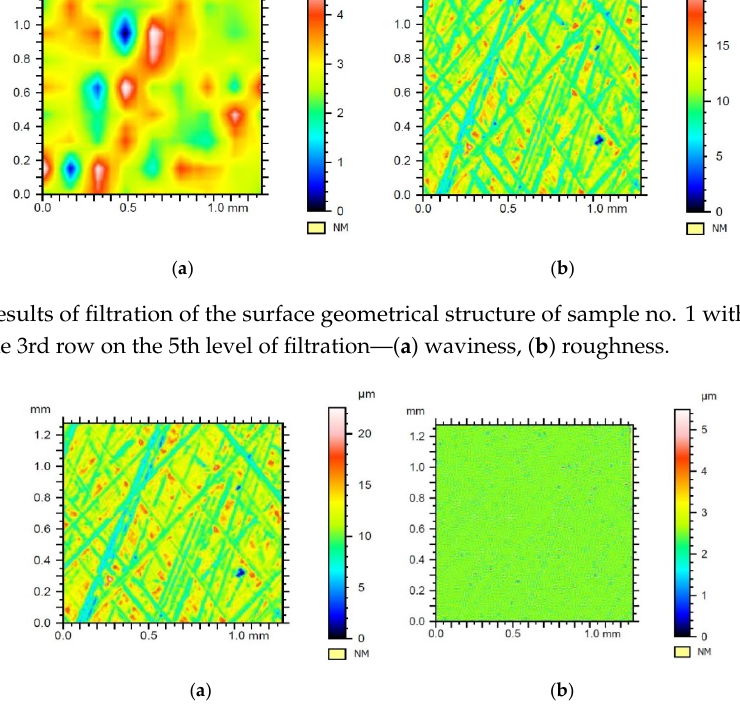
Figure 11. Results of filtration of the surface geometrical structure of sample no. 1 with Daubechies wavelet of the 6th row with the 1st level of filtration—( a ) waviness, ( b ) roughness.